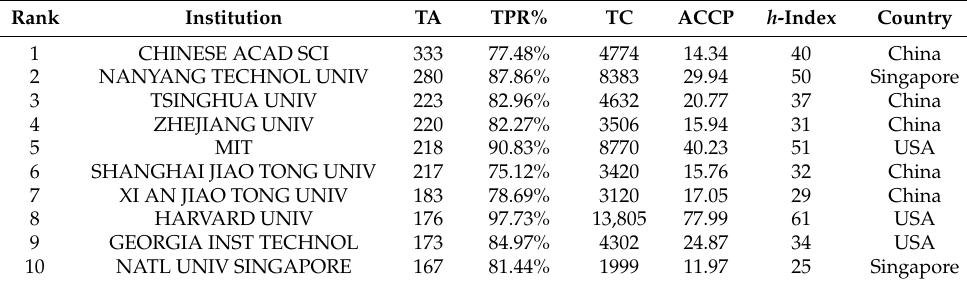
Table 2. The top 10 most productive